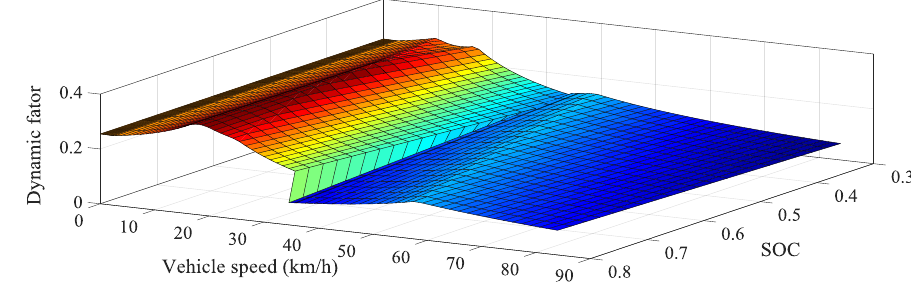
Figure 8. Dynamic factor of the hybrid HDV with SOC.